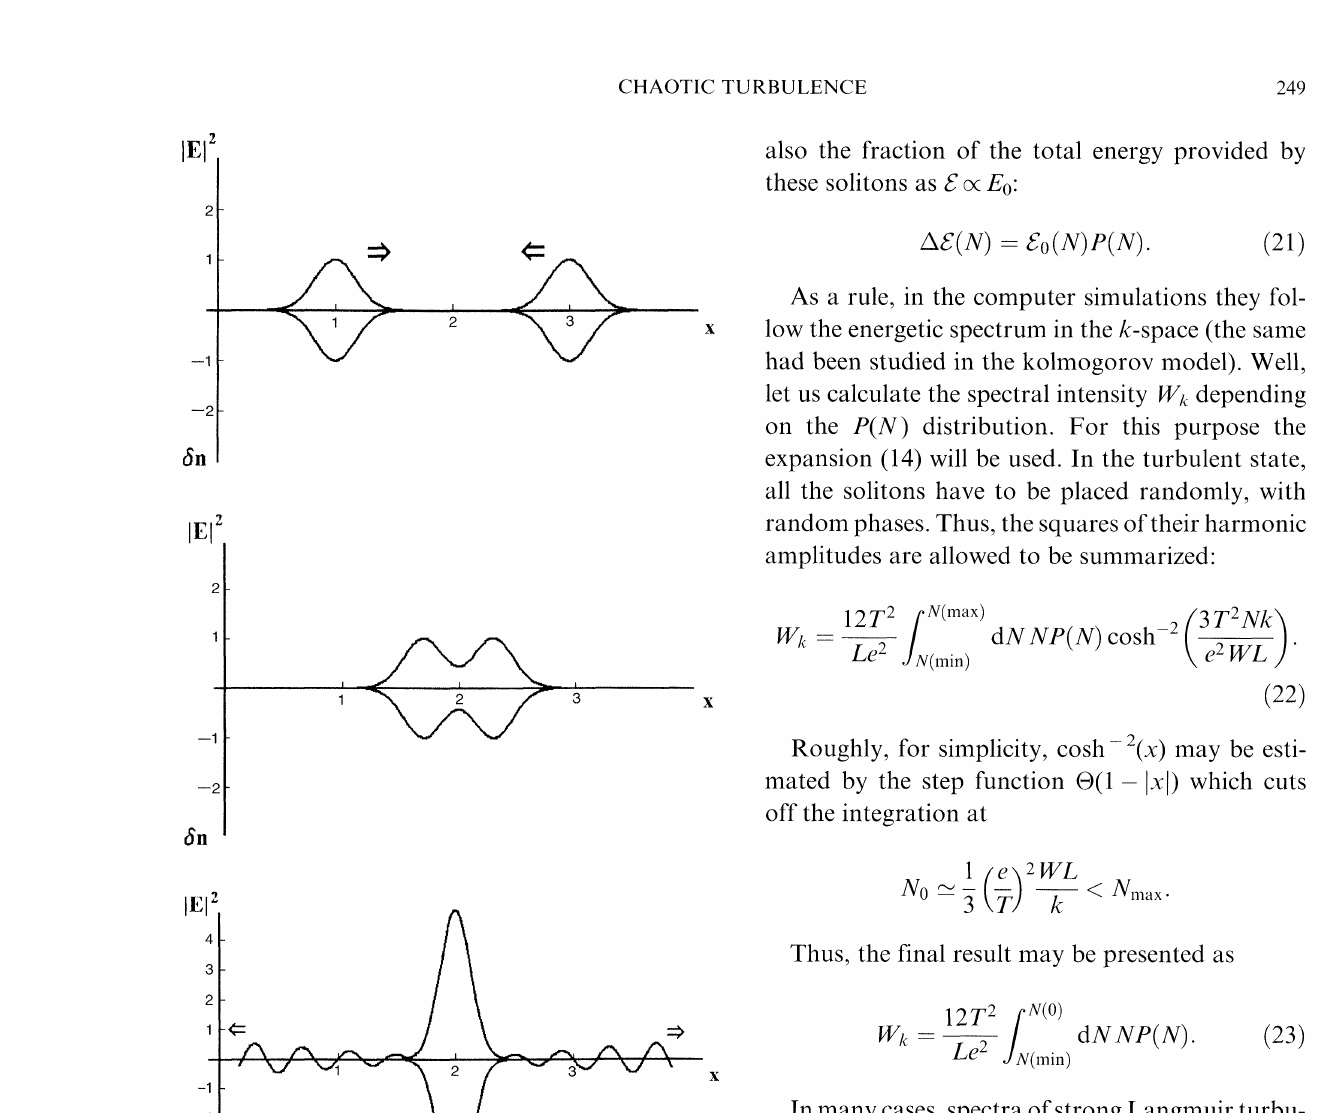
FIGURE 4 Three stages of the process of fusion of two Langmuir